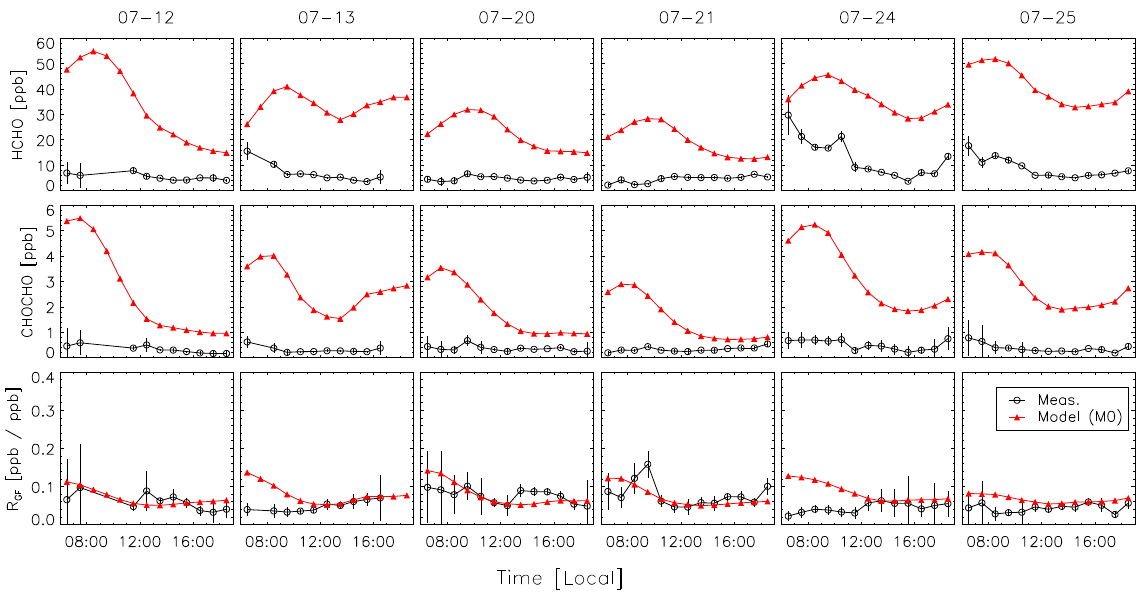
Figure 2. Measured and modeled HCHO, CHOCHO, and CHOCHO/HCHO ratios ( R GF ) for the 6 cloud-free days during the PRIDE- PRD2006 campaign. The modeled values are from the model base case (M0). The error bar refers to the 1 σ statistic error of the measurements. Fig. 2. Measured and modeled HCHO , CHOCHO , and CHOCHO / HCHO ratios ( R GF ) for the 6 cloud-free days during the PRIDE-PRD2006 campaign. The modeled values are from the model base-case (M0). The a decrease of R GF from morning to noon and stable R GF val- ues in the afternoon (Fig. 2). Compared to the discrepancy error bar refers to the 1 σ statistic error of the measurements. for the HCHO and CHOCHO concentrations, the R GF cal- culated by the model (0 . 075 ± 0 . 024) is only slightly higher than that by the measurements (0 . 059 ± 0 .